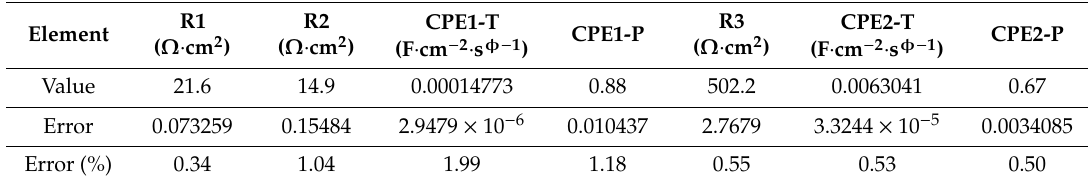
Table 5. Fitting parameters obtained from the EIS measurements of the Zn 87 Mg 9 Ca 4 alloy immersed in Ringer’s solution at 37 ◦ C for 24